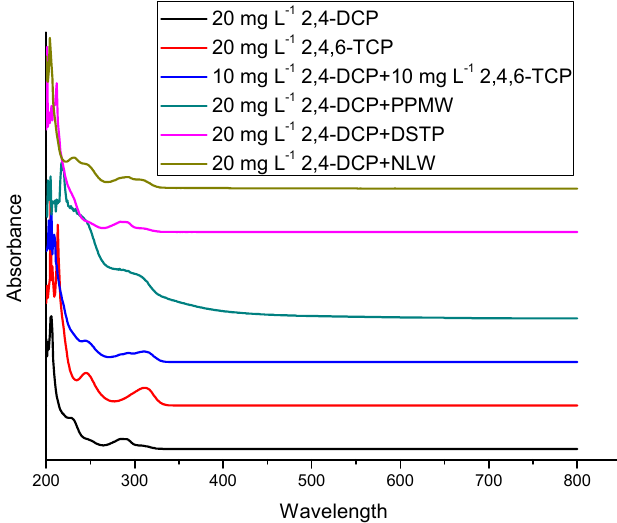
Figure 9. UV-visible absorption spectrum of different water bodies.